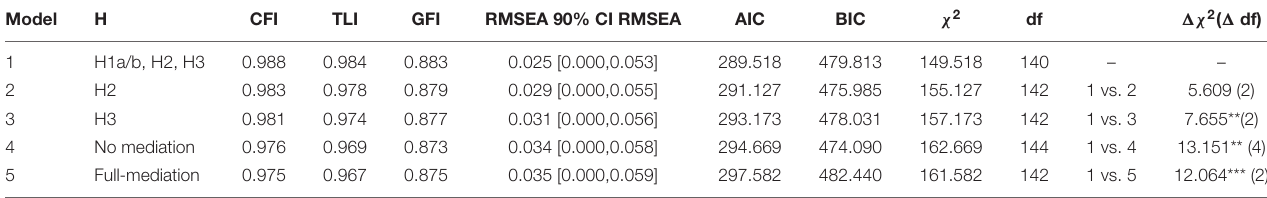
TABLE 3 | SEM results.